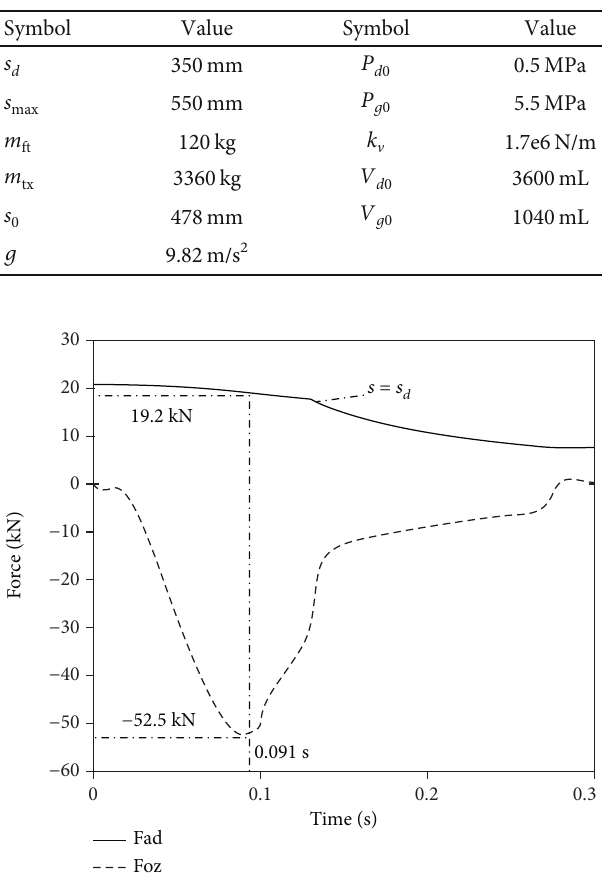
Figure 4: Time history of axial component force.